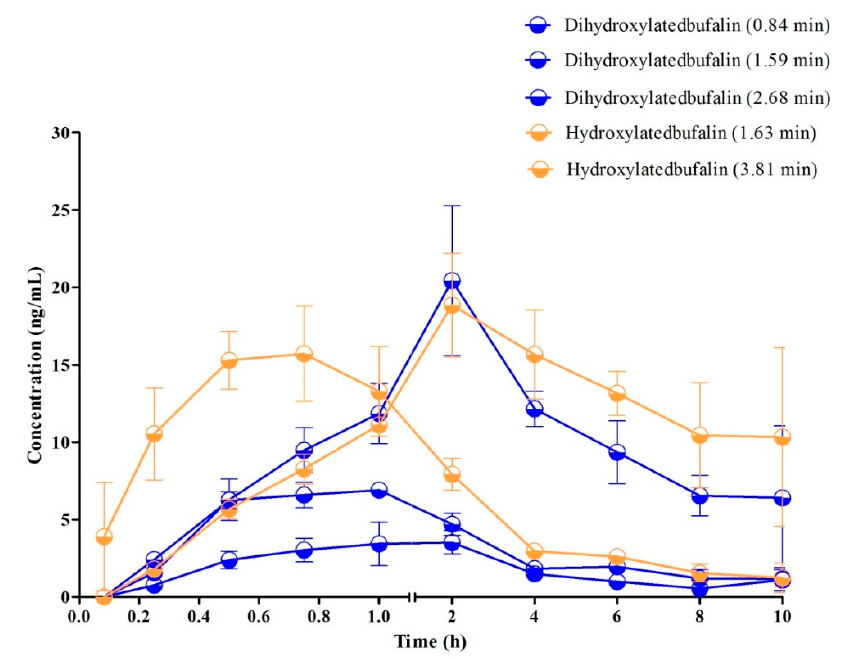
Figure 6. Mean plasma concentration–time profiles of metabolites ( C max was in the range of 2 to 25 ng/mL) in rats after oral administration of 10 mg/kg ( n = 3).